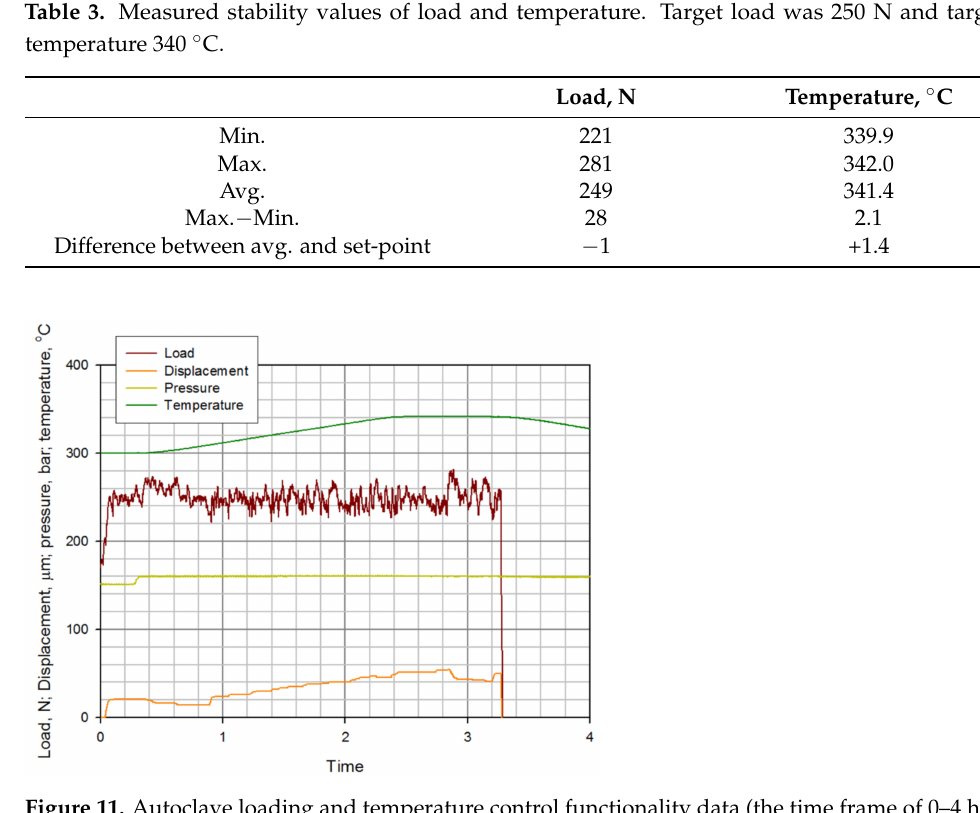
Figure 11. Autoclave loading and temperature control functionality data (the time frame of 0–4 h in this figure corresponds with the time frame of 23–27 h in Figure